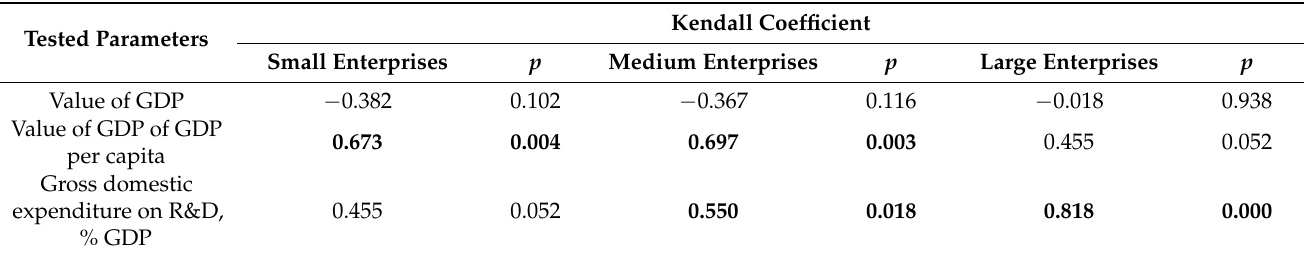
Table 13. Kendall’s tau correlation coefficient between the value of the digitalization index of small, medium and large enterprises and the basic economic parameters of the economy of CEE